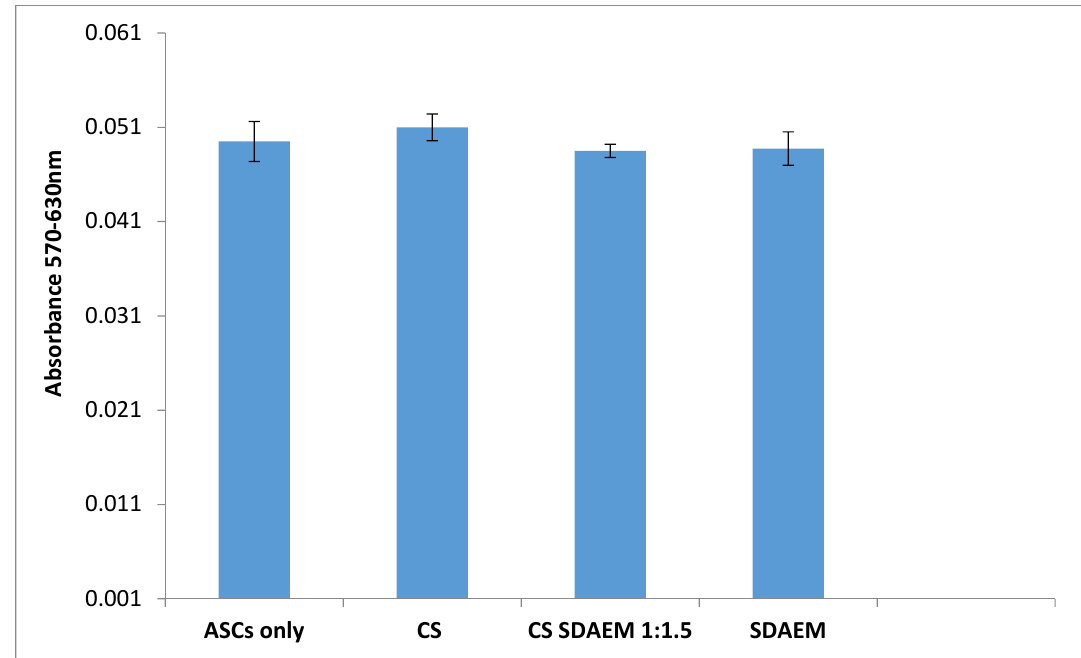
Figure 5. Cytotoxicity of CS, SDAEM and CS-SDAEM through MTT assay on adipose tissue-derived mesenchymal stem cells (ASC), UV absorbance of the samples.